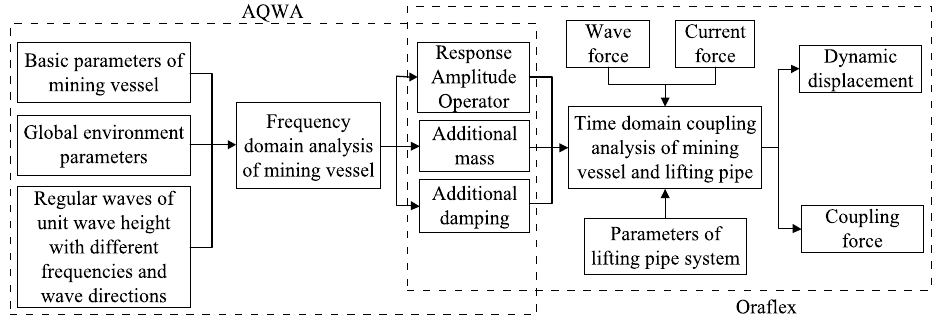
Figure 10. Time domain coupling simulation process of deep sea mining system (created by Microsoft Visio 2019 software, URL: https:// www. micro softs tore. com. cn/ visio/ visio- stand ard-